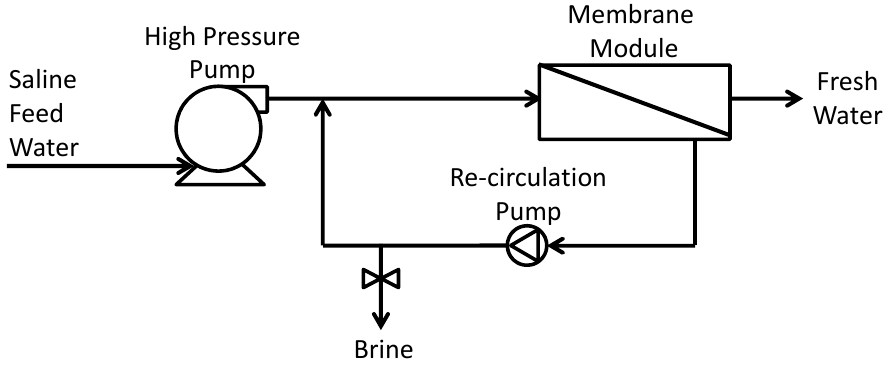
Figure 11. A schematic design of an apparatus for Closed Circuit Desalination (CCD)